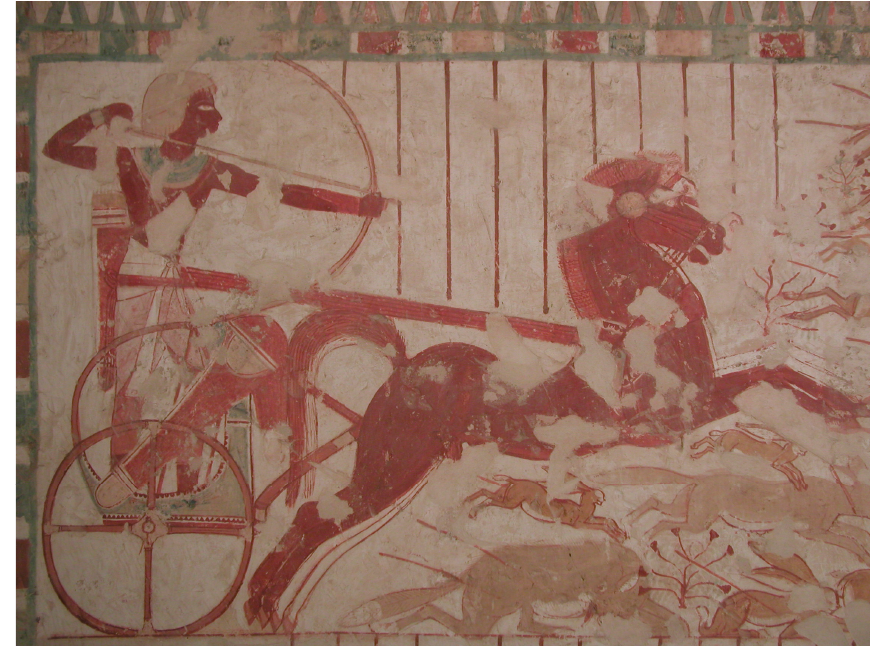
Figure 1. Hunting scene from the tomb of Userhat. TT56. Photo: JJ Shirley.